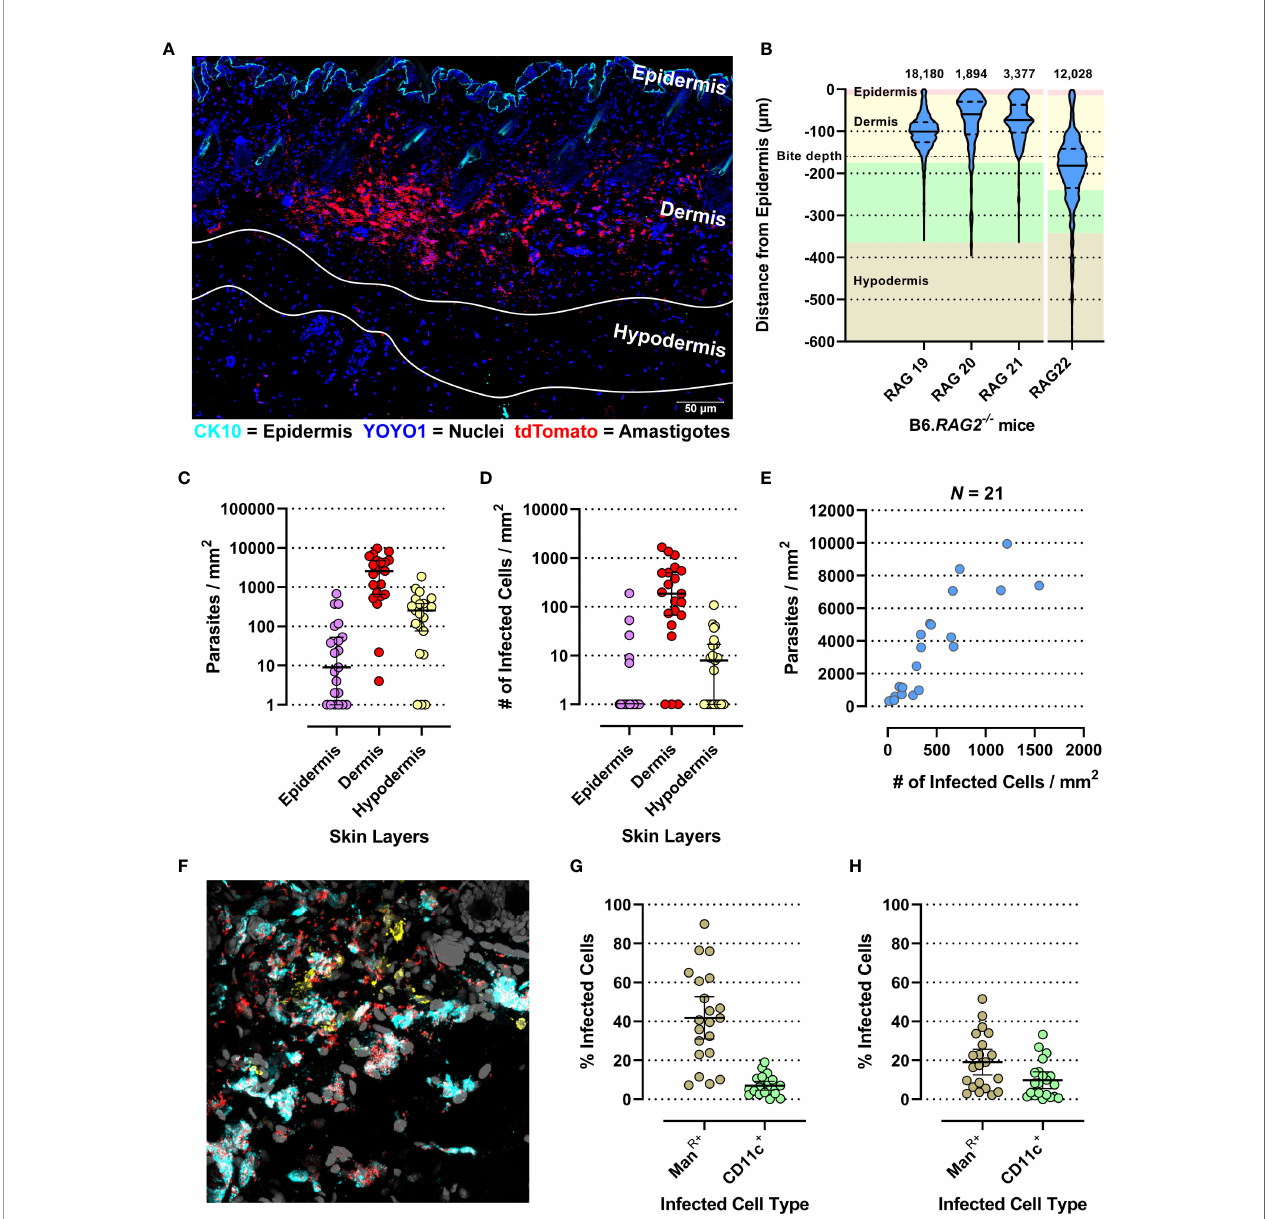
FIGURE 1 | Evaluation of micro-scale parasite distribution in the skin. (A) Representative tile-scan z-stacked confocal microscope image of a 20-µm-thick skin biopsy section of the RAG19 mouse. In cyan Cytokeratin-10 (CK-10; epithelium), in blue YOYO-1 (nuclei and kinetoplasts) and in red tdTomato ( L. donovani amastigotes). The white lines demarcate the hypodermis ’ s upper and lower edges. Their locations were determined in raw images prior to linear unmixing when the auto fl uorescence of adipocytes was still visible. (B) Violin plot of normalized L. donovani amastigote distance from the epithelium as measured by the Volocity approach in confocal images. The number of amastigote distances measured are given above each plot. RAG19 – 21 were female and RAG22 was a male B6. RAG2 -/- mouse. The background color code for skin layer thickness: pink = epidermis, yellow = dermis, green = hypodermis, tan = subcutaneous tissue. The average sand fl y proboscis skin penetration depth is marked by a dot-dashed line. (C – H) Evaluation of amastigote localization in the skin by the StrataQuest approach in confocal images. Each circle is representative for a measurement from one of 21 analyzed images across RAG19-22. (C) Parasite counts/skin layer (Friedman test: p < 0.0001; Dunn ’ s post hoc test: Epi vs. Der: p < 0.0001, Epi vs. Hypo: p = 0.0407, Der vs. Hypo: p = 0.0047). (D) Counts of infected host cell/ skin layer (Friedman test: p < 0.0001; Dunn ’ s post hoc test: Epi vs. Der: p < 0.0001, Der vs. Hypo: p = 0.0021). (E) Correlation plot of total parasite counts/skin section against all infected cells/skin section (Spearman r : p < 0.0001, r = 0.8766, 95% CI: 0.7091 – 0.9505). (F) Representative image of the Man R (cyan) and CD11c labelling (yellow) together with the endogenously expressed tdTomato signal from L. donovani amastigotes (red) and YOYO-1-labeled nuclei (gray). (G) Percent of detected infected Mannose Receptor positive cells of all infected cells compared to detected infected CD11c + cells of all detected infected cells (Paired t -test: p < 0.0001, 95% CI: − 33.11 to − 18.02). (H) Percent of detected infected Mannose Receptor-positive cells of all detected Mannose Receptor cells compared to detected infected CD11c + cells of all detected CD11 + cells (paired t -test: p < 0.0001, 95% CI: − 11.82 to −